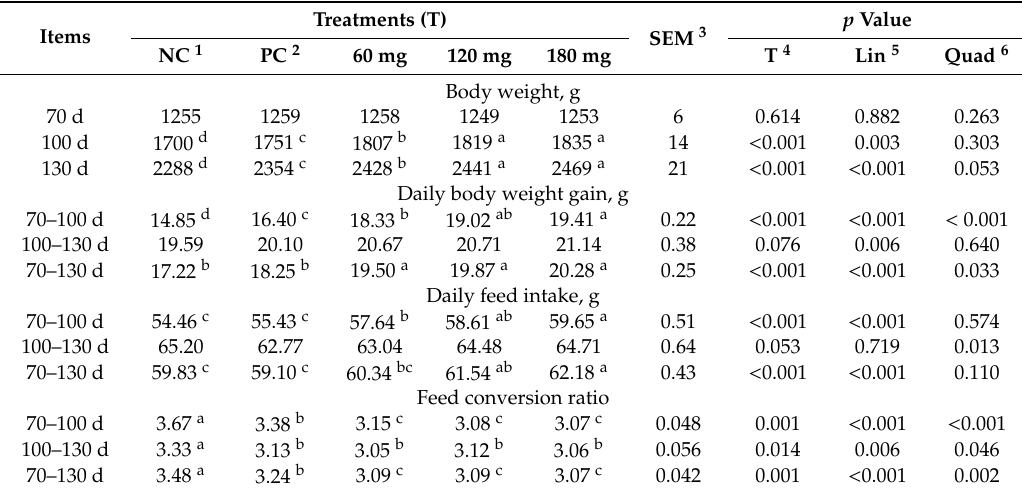
Table 3. E ff ects of thyme essential oil on the productive performance of male